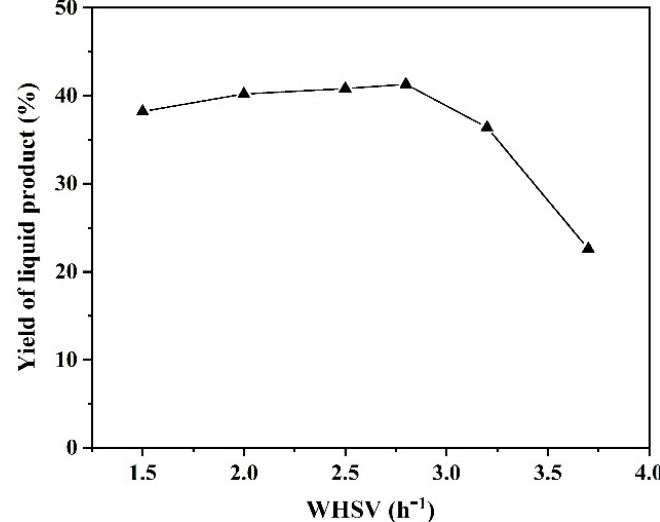
Figure 5. E ff ect of WHSV on the yield of liquid product. Reaction conditions: reaction temperature: 120 ◦ C;Si / Alratio: 25; pressure: 3.5MPa; Niprecursor: Ni(NO 3 ) 2 ; agingtemperature: roomtemperature; pretreatment temperature: 300 ◦